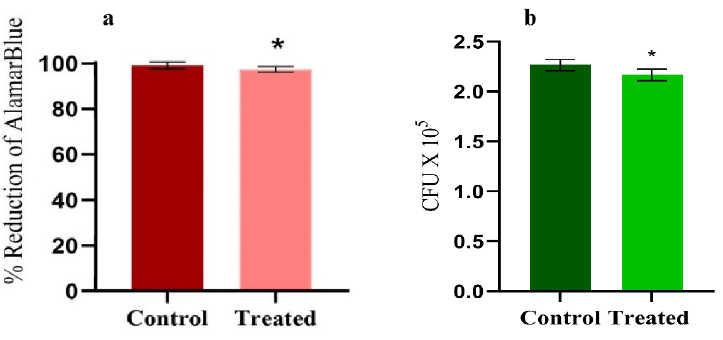
Figure 3. ( a ) AlamarBlue TM assay showing the metabolic viability of the control and Linalool-treated S. pyogenes at its MBIC (0.004%). ( b ) CFU analysis of the control and Linalool-treated S. pyogenes exhibiting the non-antibacterial nature of Linalool at its MBIC (0.004%). Error bars represent the S.D. Asterisks indicate statistical significance ( p <